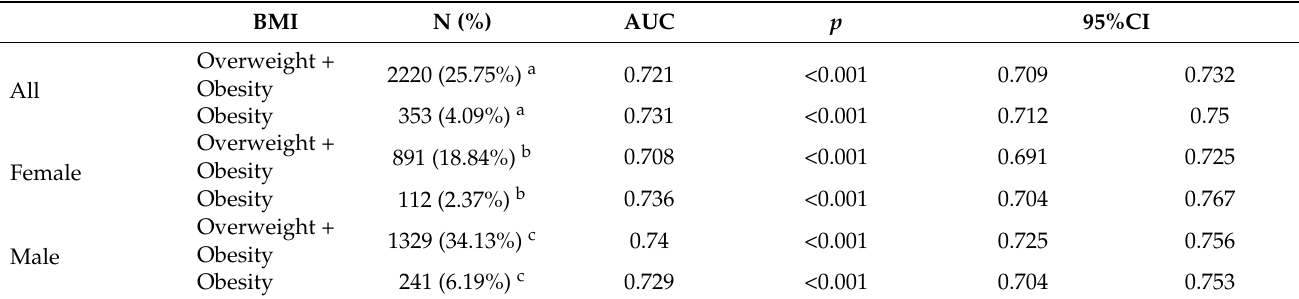
Table 5. The results of the ROC curves analysis.